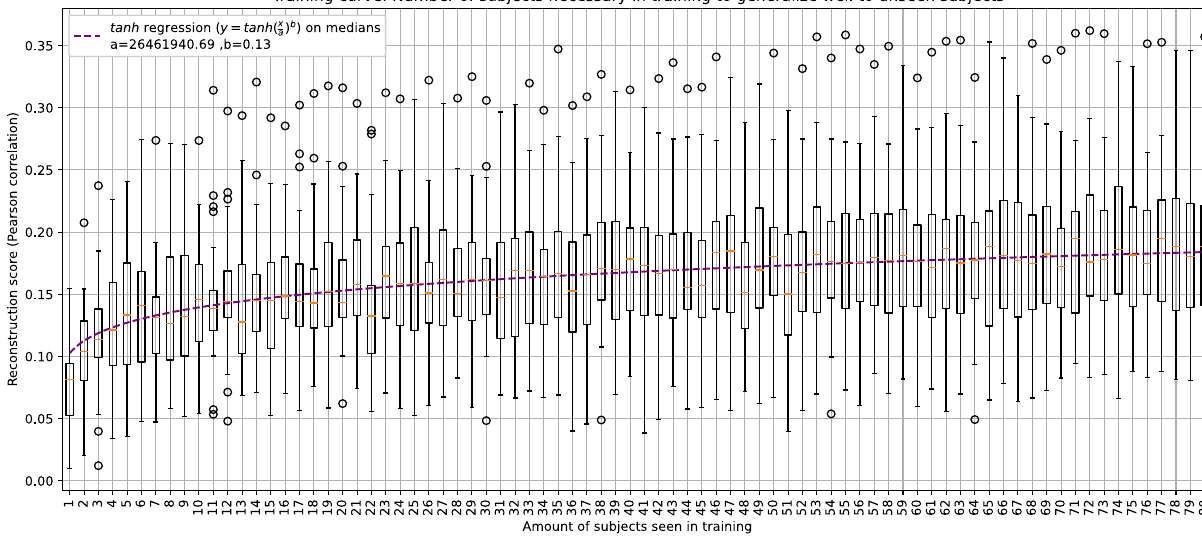
Figure 6. The VLAAI network was trained using 1–80 subjects of the single-speaker stories dataset and evaluated on the holdout dataset (26 subjects). Each point in the boxplot is the reconstruction score for a subject, averaged across stimuli. Median reconstruction scores increase with the number of subjects seen during training.